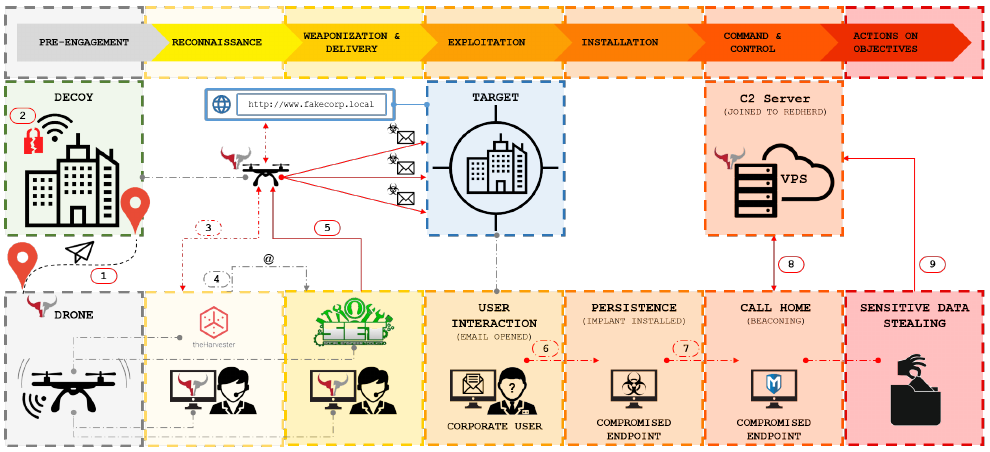
Figure 14. Attack simulation